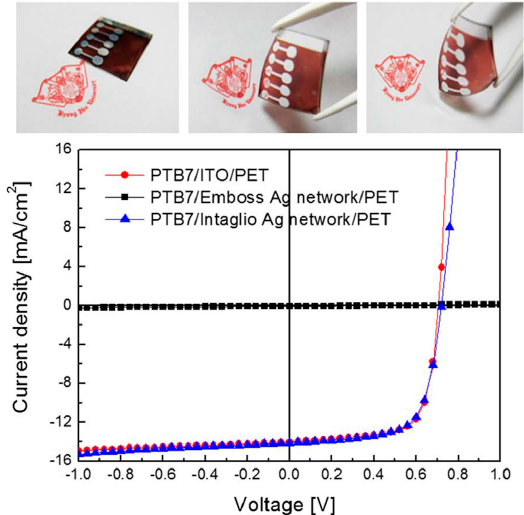
Figure 11. J–V curves of the flexible polymer solar cells based on ITO, emboss and intaglio-type Ag network electrodes. The upper pictures show the flexibility of the device using intaglio-type Ag network electrodes. Reprinted from [93], Copyright 2016, with permission from Elsevier.